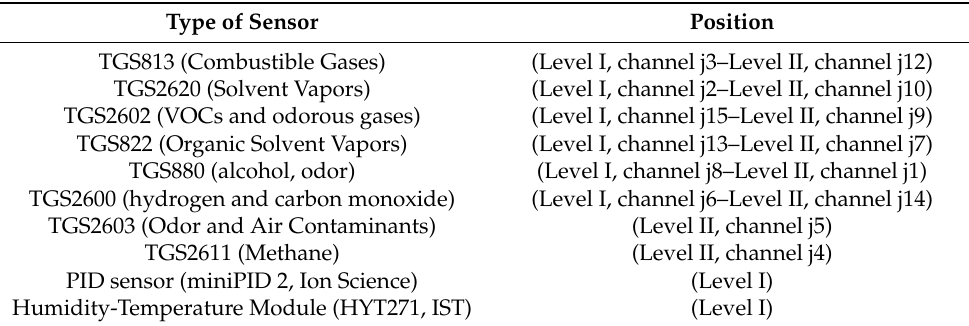
Figure 2. IOMS layout. Table 1. IOMS sensors and related channels. Table 1. IOMS sensors and related